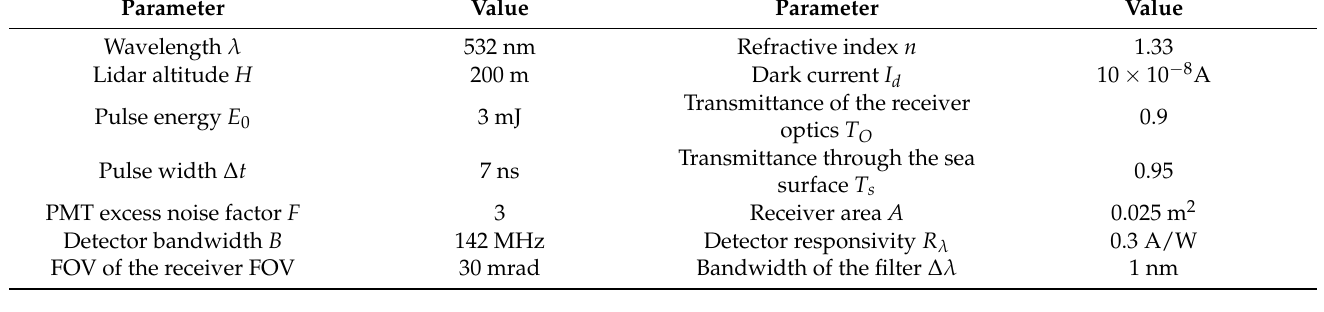
Table 3. Parameters of Hawkeye system parameters [47].